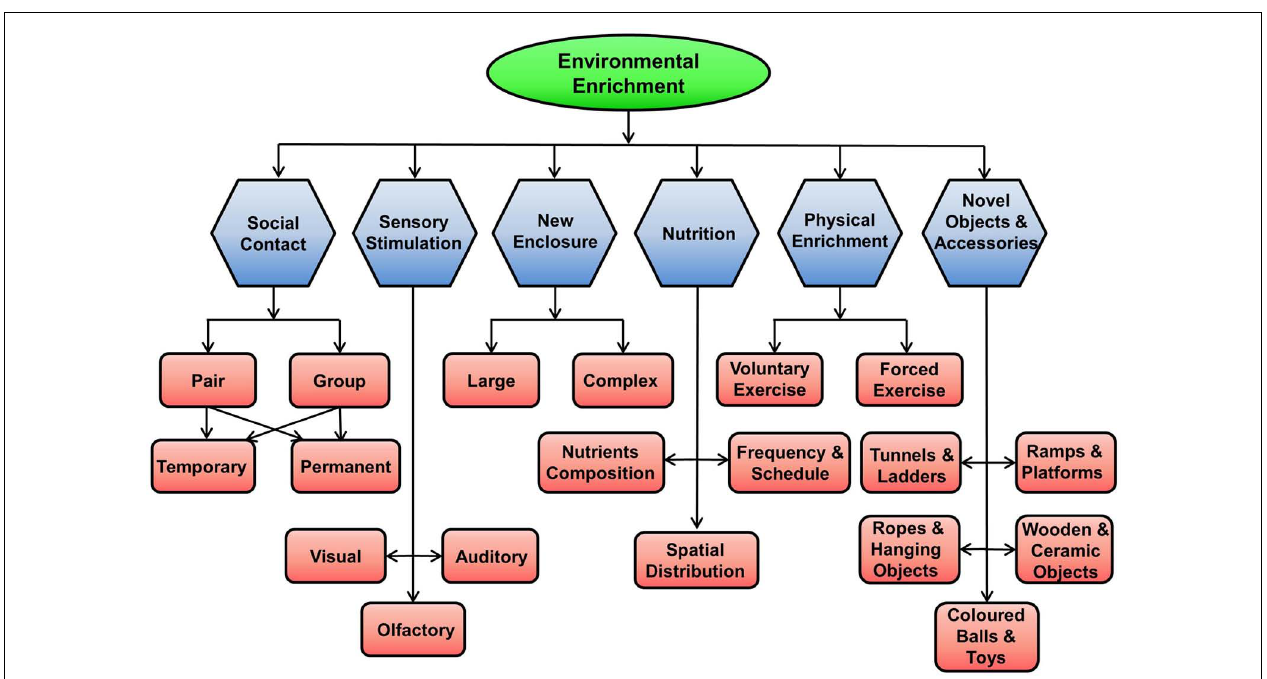
FIGURE 2 | Methods of enriching the environment for rodents in captivity. EE for rodents in captivity can be achieved by providing them with social contact (pair, group, permanent, temporary), physical activity using